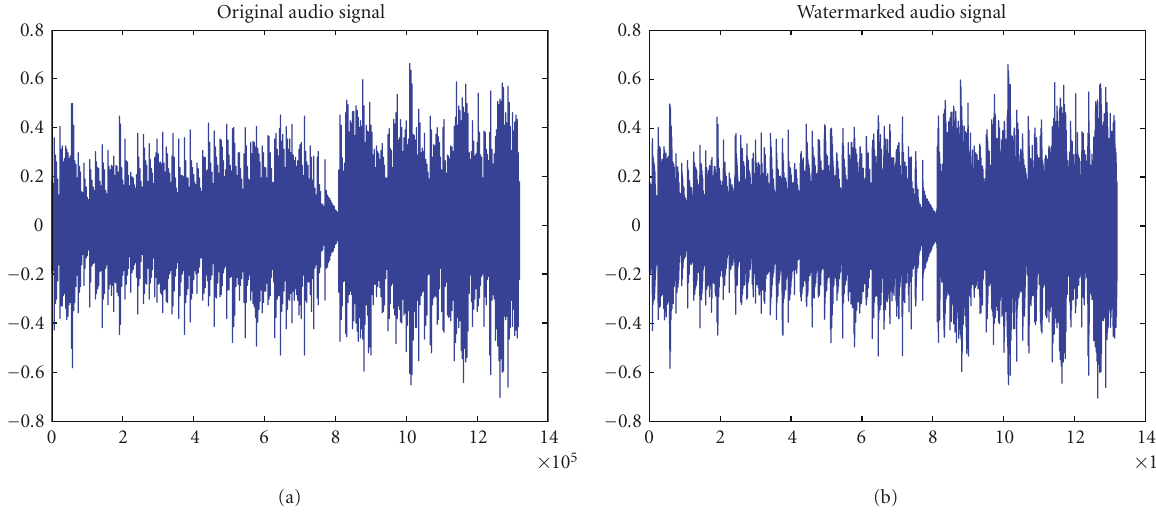
Figure 10: (a) Original audio signal (Classical1), (b) watermarked audio signal.